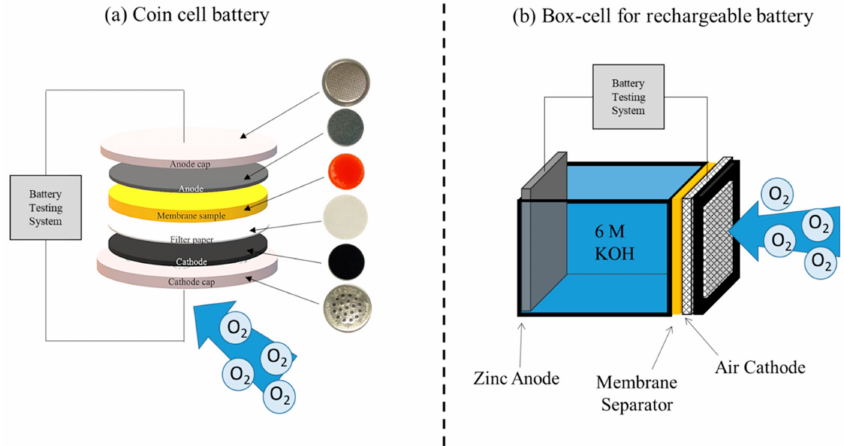
Schematic view of zinc–air battery (ZAB) in ( a ) primary cell and ( b ) secondary cell